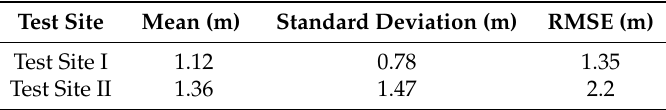
Table 4. Shoreline accuracy